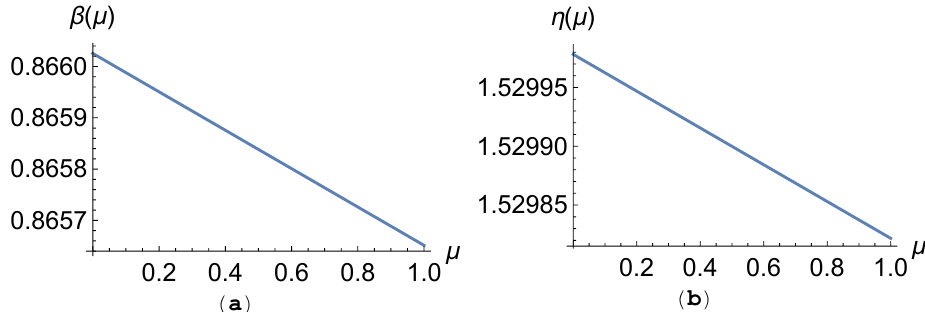
Figure 8. Numerical solutions of ( a ) β ( µ ) and ( b ) η ( µ ) demonstrating convergence to β ∗ and η 0 , respectively, as µ → 0, obtained using Mathematica. The behaviour of η ( µ ) is consistent with our result that η ( µ ) is a nonincreasing function of µ . Parameter values: r e = 1.1, r d = 0.2, D e = 0.3, D d = 1.5, e = 0.001 and d =